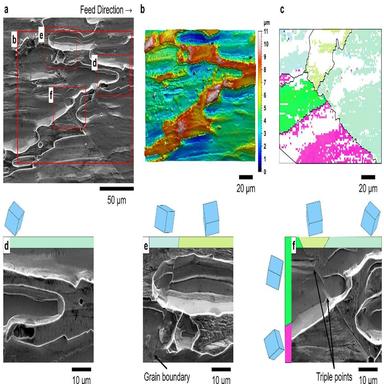
Striation geometries are bounded by crystalline etch facets. a) SE micrograph of area of interest v, inset boxes showing acquistion areas of further microscopic study. b) Topography reconstruction (FVM, 100× objective) of area of interest v showing relatively large height differences across the striations. c) Areas of EBSD zero solution (white pixels) are spatially correlated with topographic aberrations. d-f) Micrographs show striations are bounded by anisotropic etch facets, propagating these facets leads